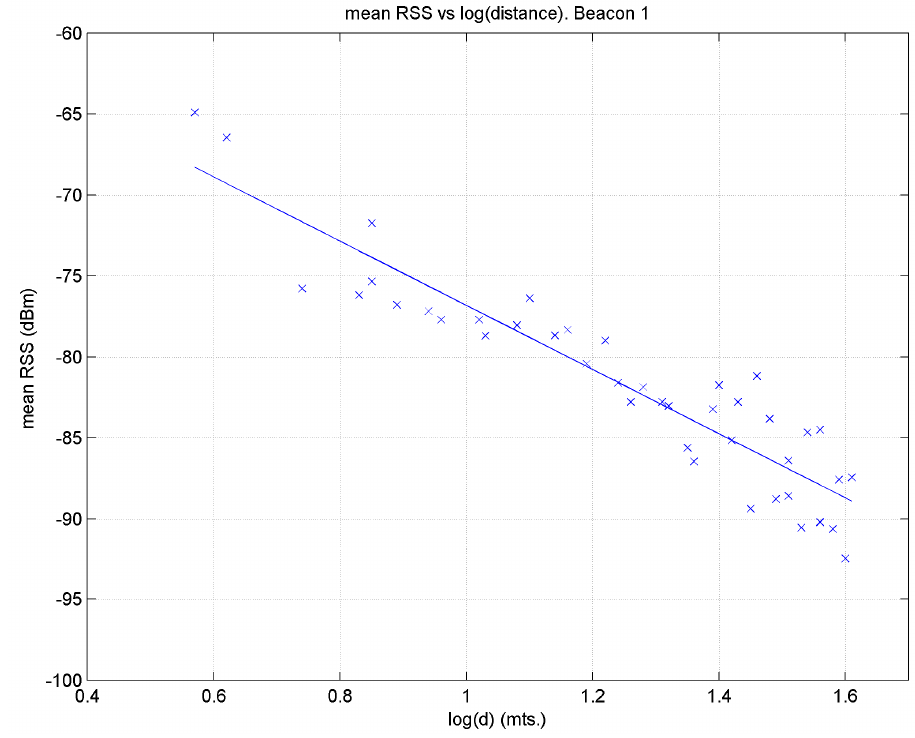
Figure 15. Linear regression for beacon 1 using all the reference points. Sensors 2017 , 17 , 1299